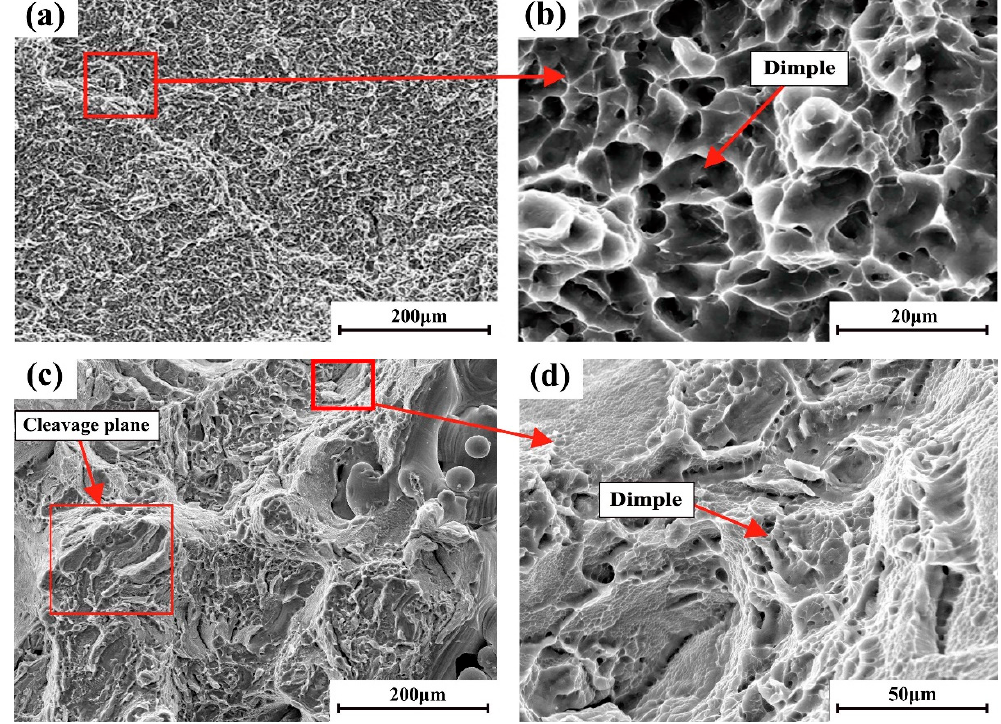
Figure 10. SEM images of fracture morphology of tensile testing: ( a ) thermally treated sample (500×); ( b ) thermally treated sample (5000×); ( c ) as built sample (500×); ( d ) as built sample (2000×).